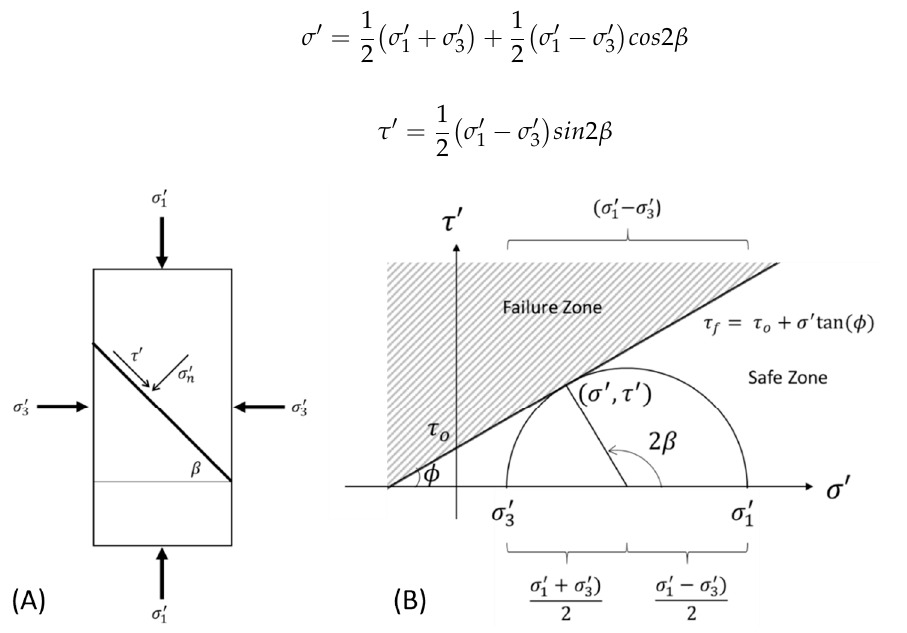
Figure 1. ( A ) Mohr–Coulomb failure criteria of a cylindrical sample. ( B ) Mohr circle depicting the failure criteria.